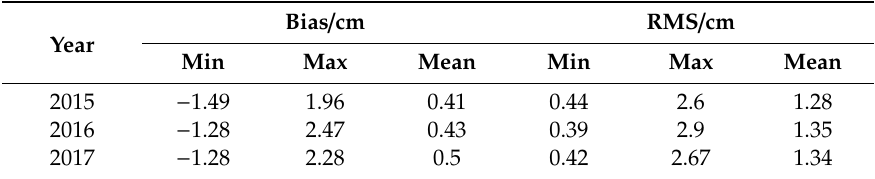
Table 1. Descriptive statistics of the bias and root mean square (RMS) for the Modern-Era Retrospective analysis for Research and Applications (MERRA-2) zenith tropospheric delay (ZTD) tested using the IGS ZTD for 2015 to